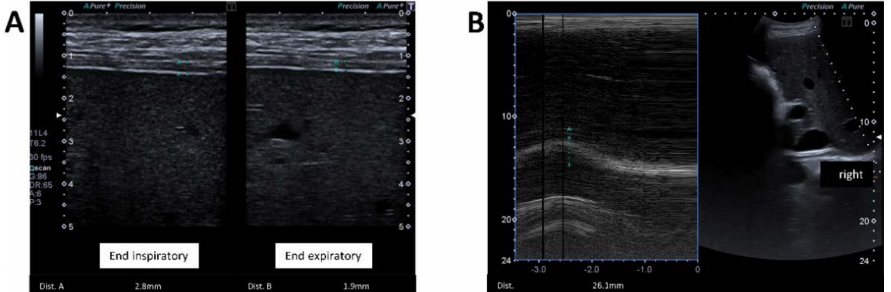
Figure 1. ( A ) Sonographically determined diaphragm thickness. Two-dimensional real-time mode with the end-inspiratory/-expiratory thickness of the right diaphragm. Sonographic window: midax- illary line at the level of the diaphragmatic apposition zone. Measurement points: diaphragmatic and peritoneal pleural lines. ( B ) Sonographically determined diaphragmatic excursion. M mode during quiet breathing in the supine